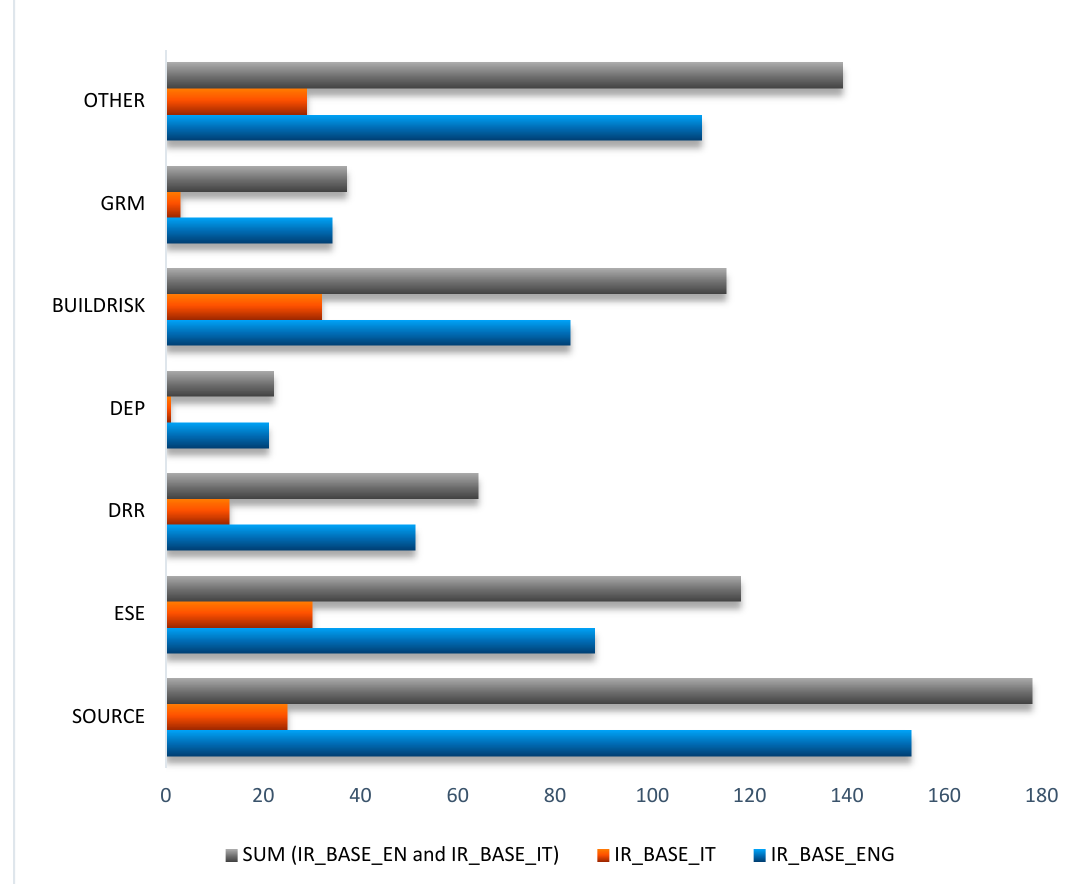
Figure 7. Total number of documents for each database and topic/(sub)cluster.